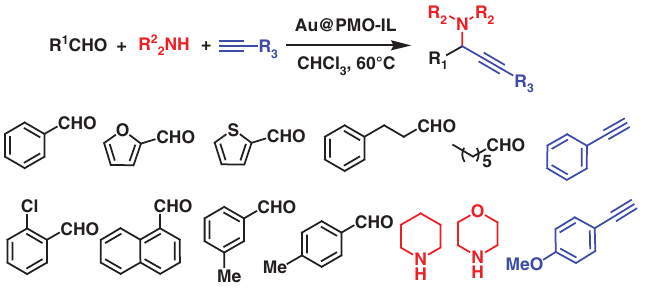
Scheme 15 A 3 -coupling reaction of a combination of aldehydes, secondary amines, and terminal alkynes catalyzed by